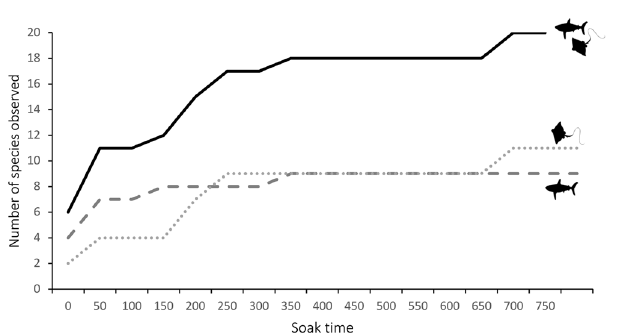
Figure 4. Cumulative number of elasmobranchs ( ➖ ), sharks ( ), and rays (